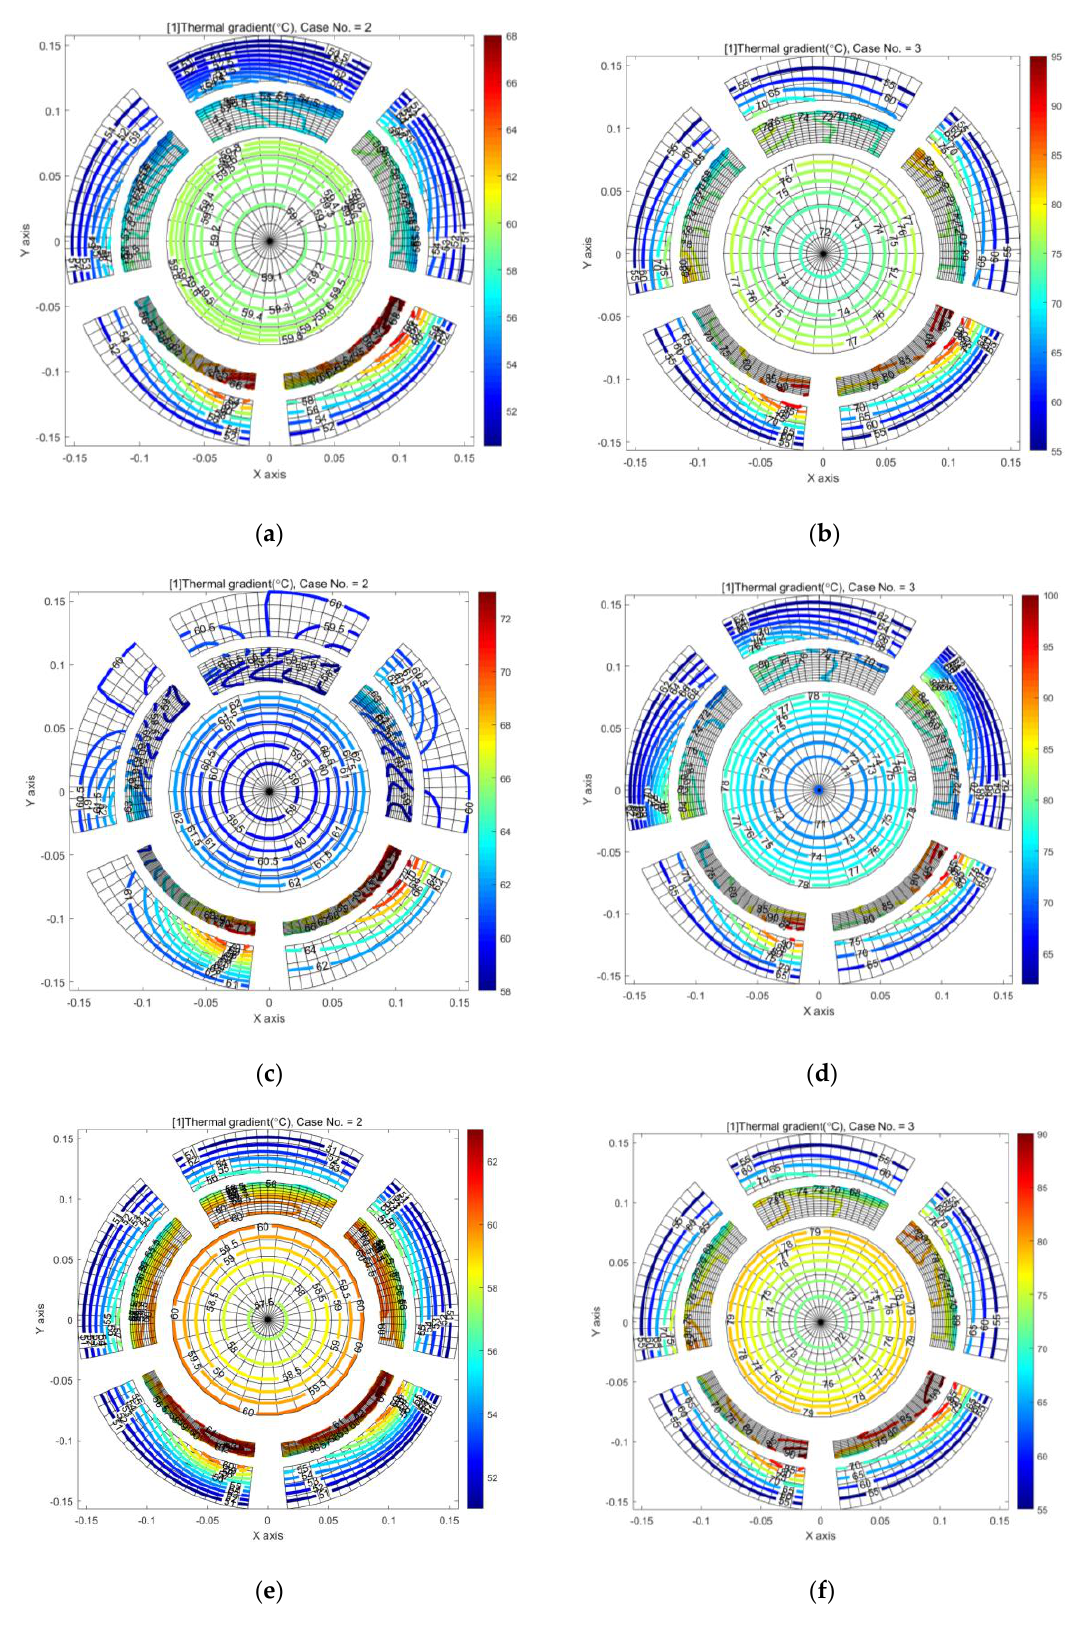
Figure 12. Temperature distribution at the axial center: ( a ) T Shaft = 60 °C (1000 rpm); ( b ) T Shaft = 60 °C (3600 rpm); ( c ) T Pad = 60 °C (1000 rpm); ( d ) T Pad = 60 °C (3600 rpm); ( e ) T Lube = 60 °C (1000 rpm); ( f ) T Lube = 60 °C (3600 rpm).